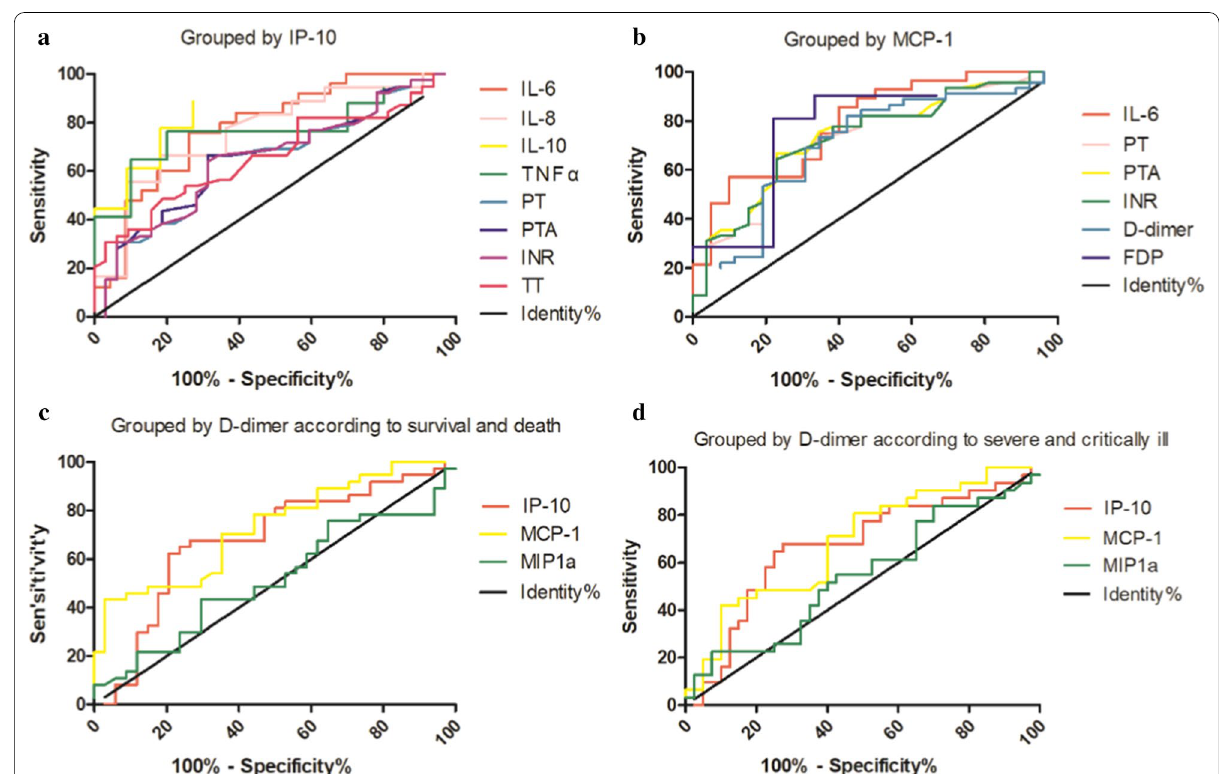
Fig. 1 ROC curves of the significant results divided by